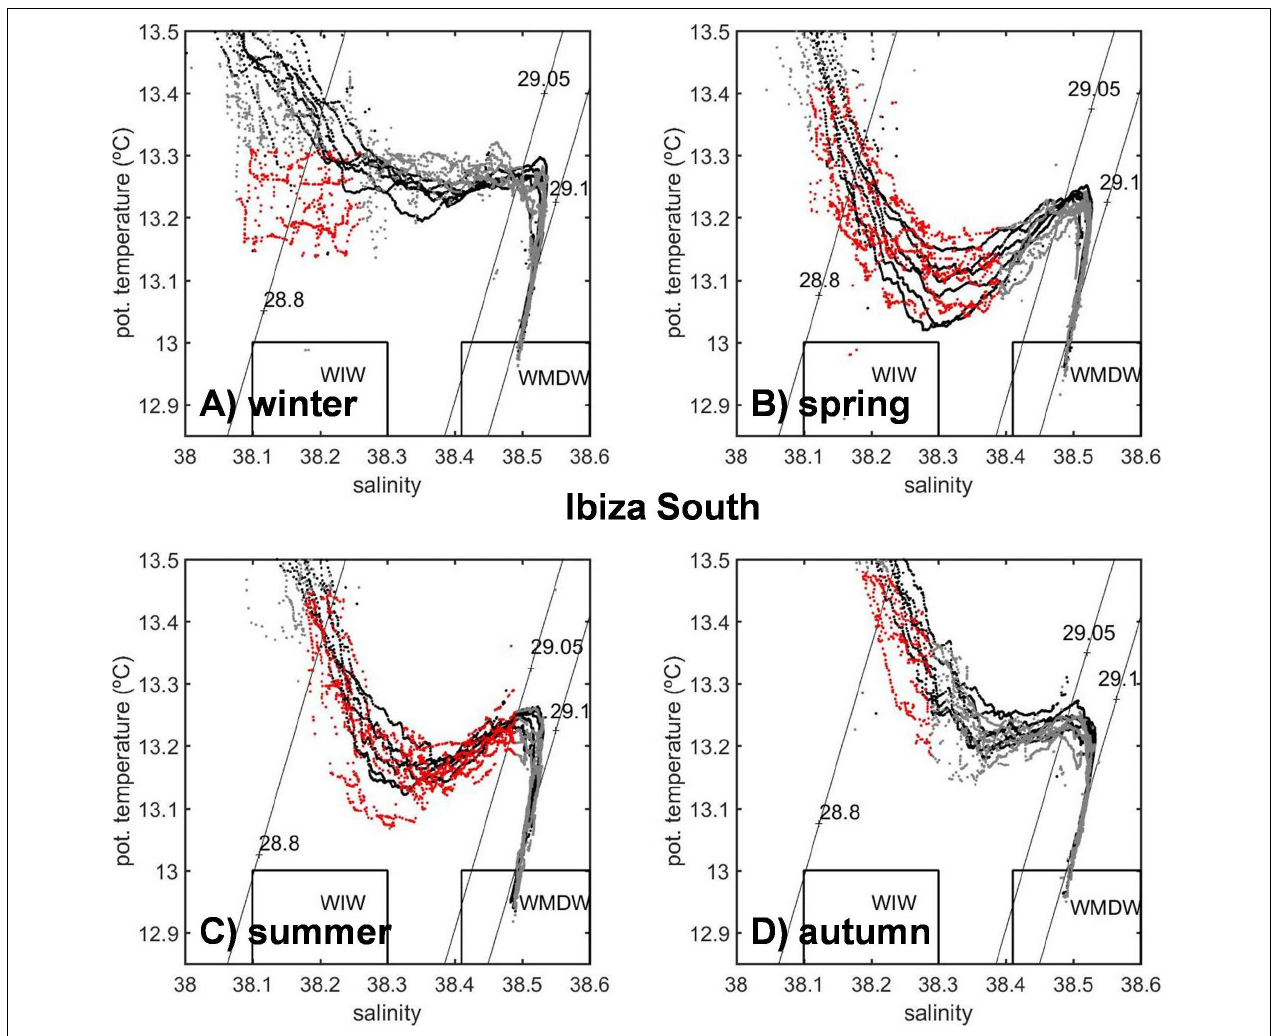
FIGURE 8 | Same as Figure 6 for the Ibiza South section. Winter (A) , Spring (B) , Summer (C) , Autumn (D)